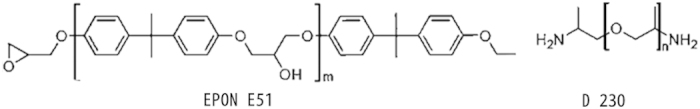
Molecular Formula of E51 and D230.